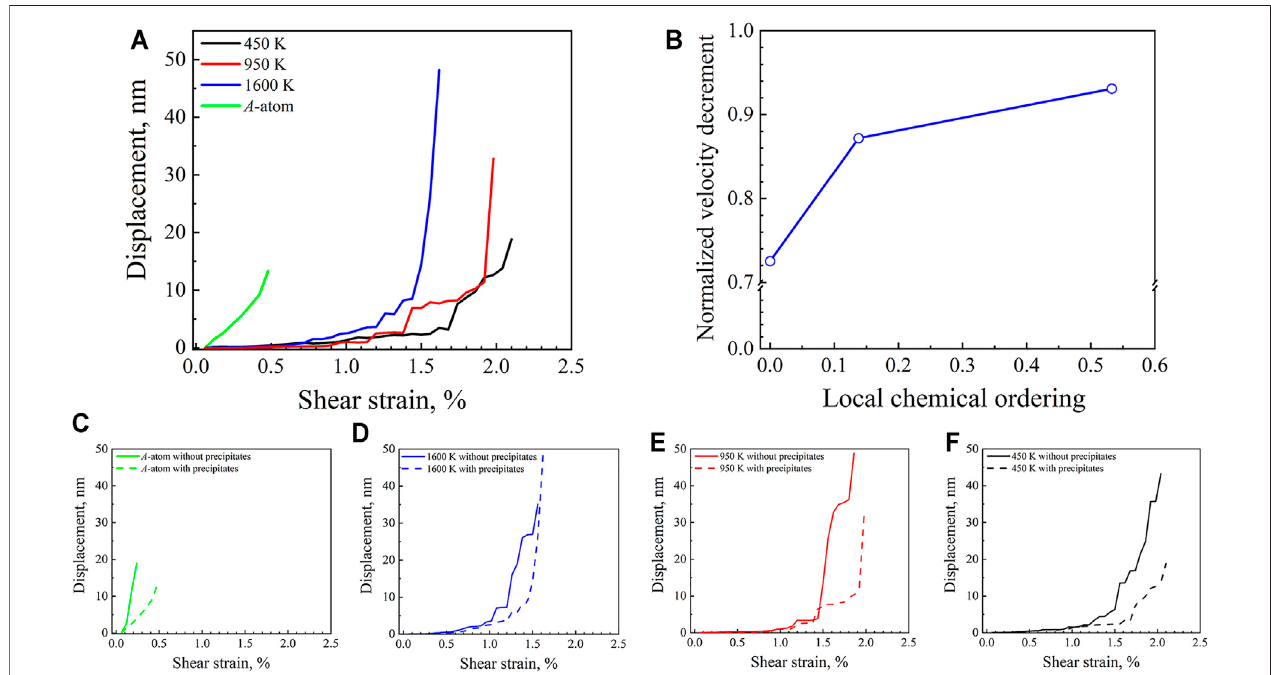
FIGURE 8 | (A) Average displacements for the leading partial dislocation as a function of the shear strain for various samples with nanoprecipitates. (B) The normalized velocity decrement between the samples without nanoprecipitates until reaching a displacement of 2 nm and the samples with nanoprecipitates until unpinning from nanoprecipitates as a function of the degree of local chemical ordering. (C) (D) (E) (F) The comparisons of the average displacements for the leading partial dislocation as a function of the shear strain for the samples with or without nanoprecipitates.